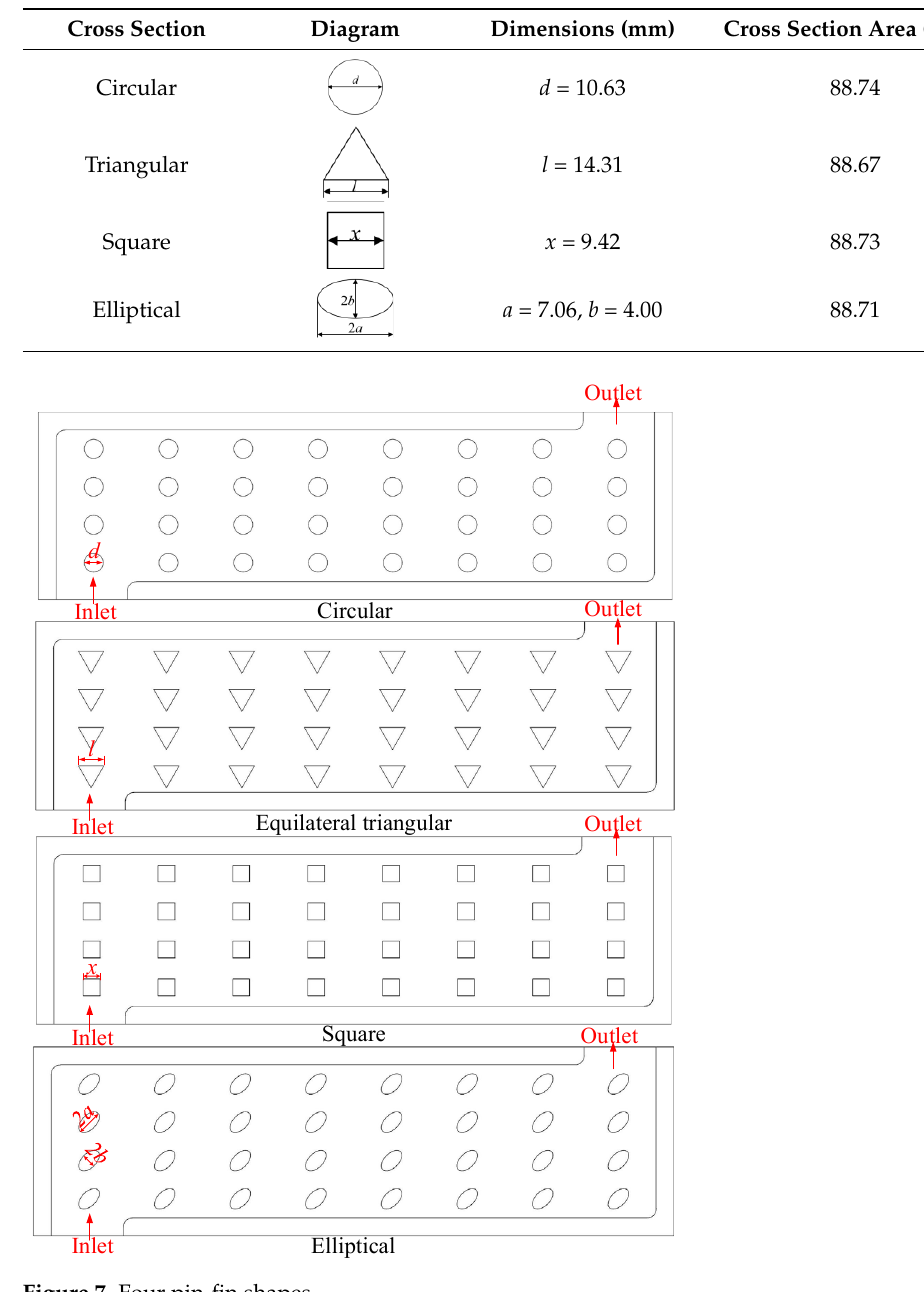
Figure 7. Four pin-fin shapes.